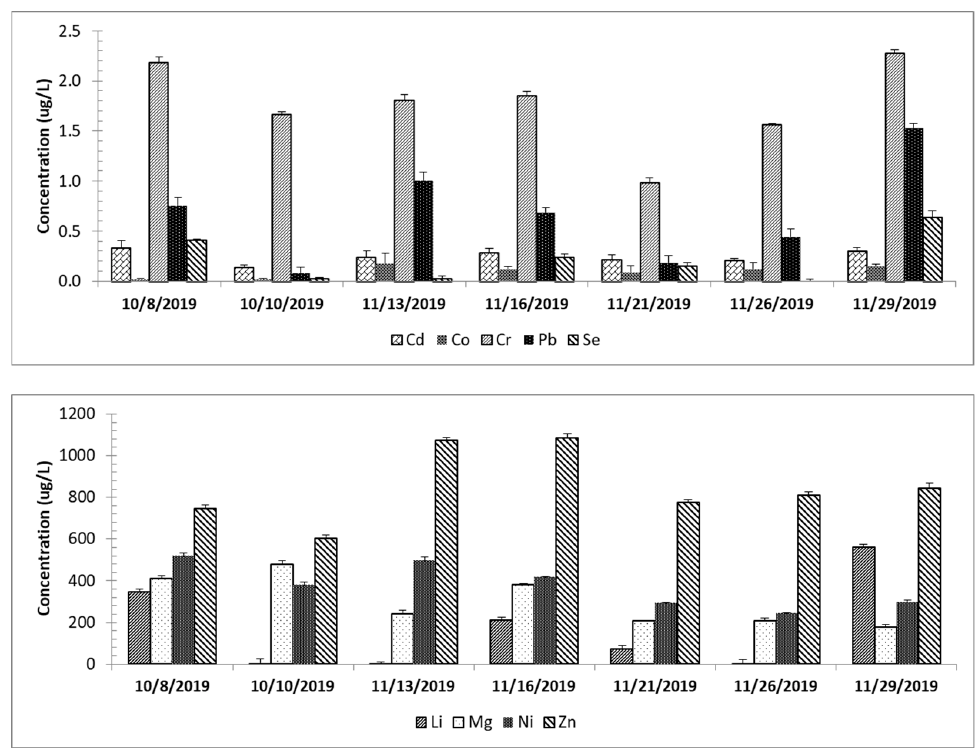
Figure 6. Dynamics of the heavy metals for each rainfall event recorded between October and November 2019.